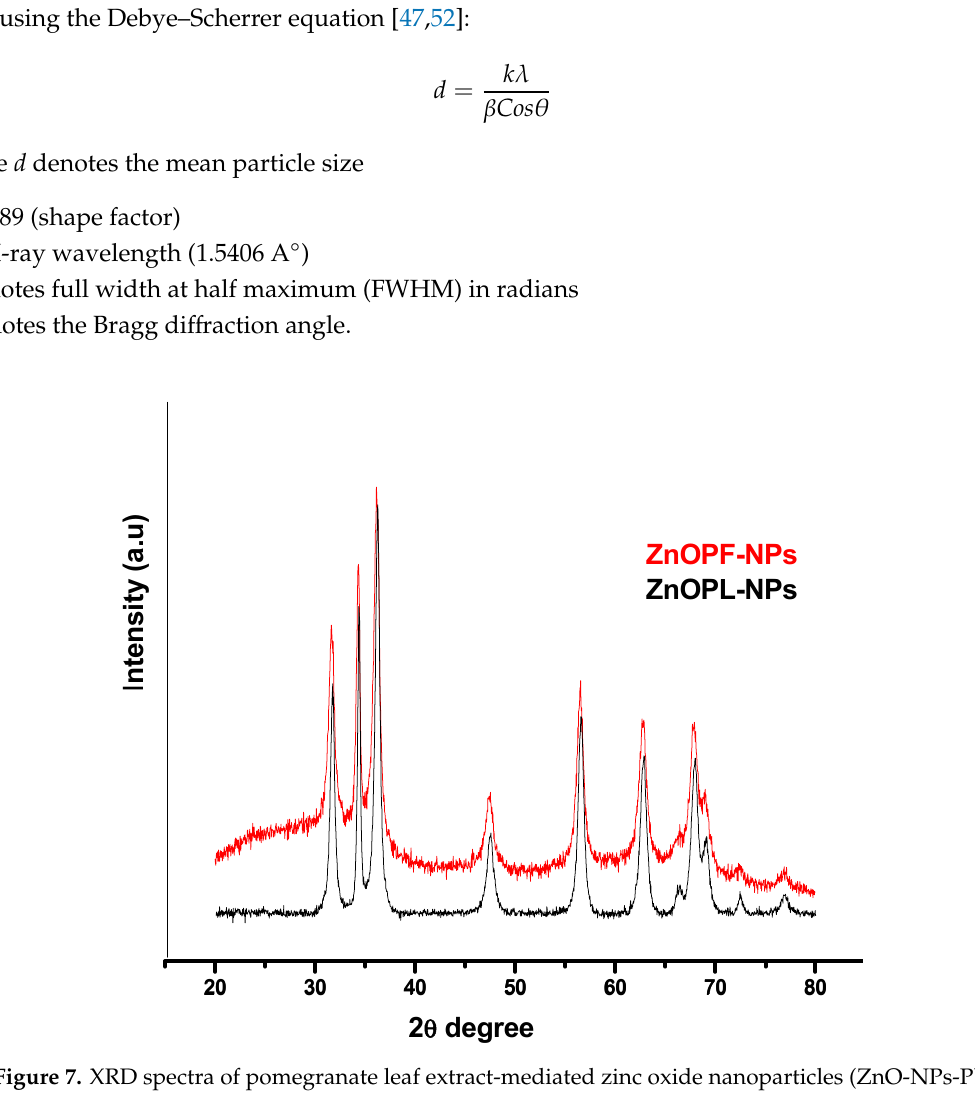
Figure 7. XRD spectra of pomegranate leaf extract-mediated zinc oxide nanoparticles (ZnO-NPs-PL) and pomegranate flower extract-mediated zinc oxide nanoparticles (ZnO-NPs-PF). From the above equation, the crystalline particle size derived for pomegranate leaf-mediated zinc oxide nanoparticles and pomegranate flower-mediated zinc oxide nanoparticles was 57.75 and 52.50 nm, respectively. These are close to the particle size values reported by Yuvakkumar et al. [7] and Dhanemozhi et al. [53], who obtained “D” values of 50.95 and 54.84 nm,